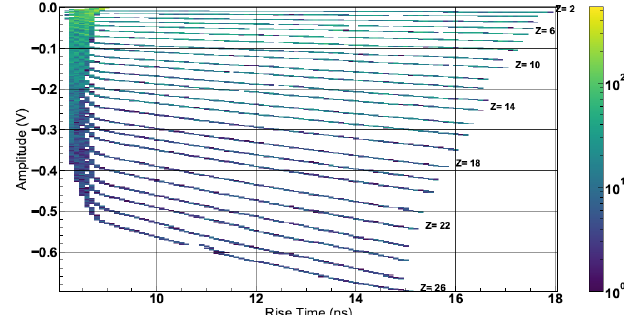
Fig. 4. Amplitude versus rise time for different particles (the value of Z is indicated on the figure). Above a rise time of about 6 ns, the curves are well separated which shows that it is possible to distinguish between different particle species and to measure their energy.